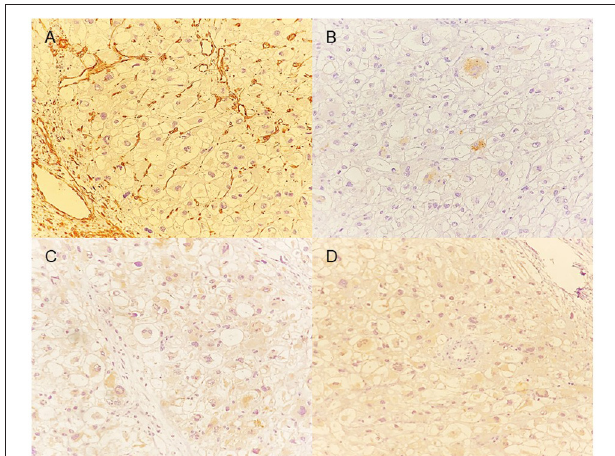
FIGURE 2 | Immunohistochemistry. (A) Micrograph of the heart tumor with vimentin that shows negative staining (–): there is no evidence of vimentin in any of the cells. The brown staining in the vessels serves as a control. (B) Micrograph of the heart tumor with the HMN-45 marker that shows mild reactivity ( + ). < 25% of the cells show staining. (C) Micrograph of the heart tumor that shows moderate reactivity ( ++ ) with synaptophysin staining. (D) Micrograph of the heart tumor that shows intense positivity ( + + + ) for the MyoD1 marker.